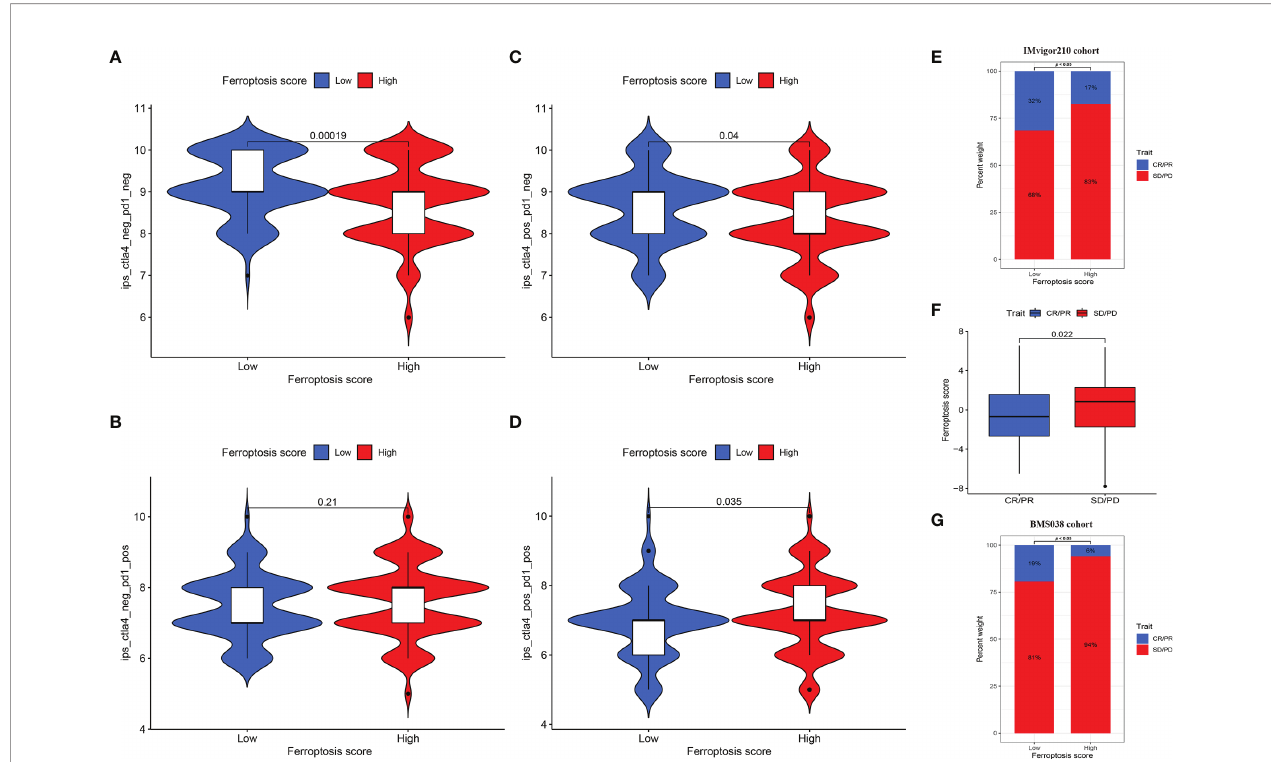
FIGURE 7 | (A – D) The differences of IPS between HSG and LSG. The IPS (A) , IPS-CTLA4 (B) , and IPS-PD1/PD-L1/PD-L2 + CTLA4 (D) were signi fi cantly different between HSG and LSG (all p < 0.05). (E) Proportion of patients with different treatment outcomes in HSG and LSG. The proportion of CR/PR patients in LSG was signi fi cantly higher than that in HSG in IMvigor210 cohort ( p < 0.05). (F) The difference of FS between treatment outcome groups ( p = 0.022). The statistical difference above was compared by the Wilcoxon test. (G) The proportion of CR/PR patients in LSG was signi fi cantly higher than that in HSG in BMS038 cohort ( p < 0.05). IPS, Immunophenoscores; HSG, high ferroptosis score group; LSG, low ferroptosis score group; CR/PR, complete response/partial